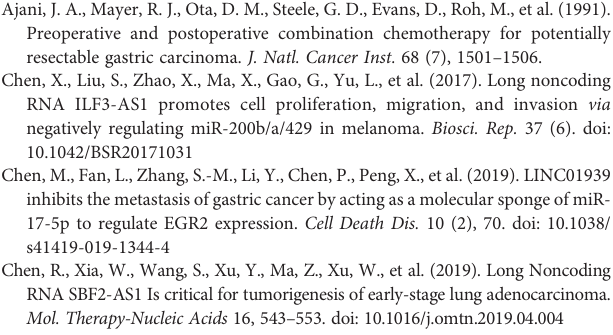
SUPPLEMENTARY TABLE 2 | The clinical information of all GC